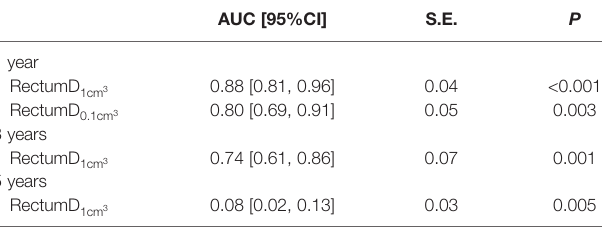
TABLE 5 | AUC of incidence of rectum morbidity grade 2 –